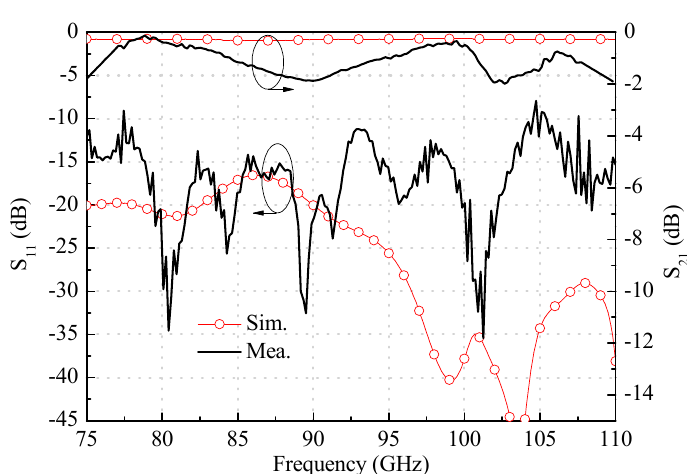
Figure 3. Back-to-back photograph of the transition. ( a ) Simulated configuration; ( b ) fabricated photograph (the upper layer is hidden).